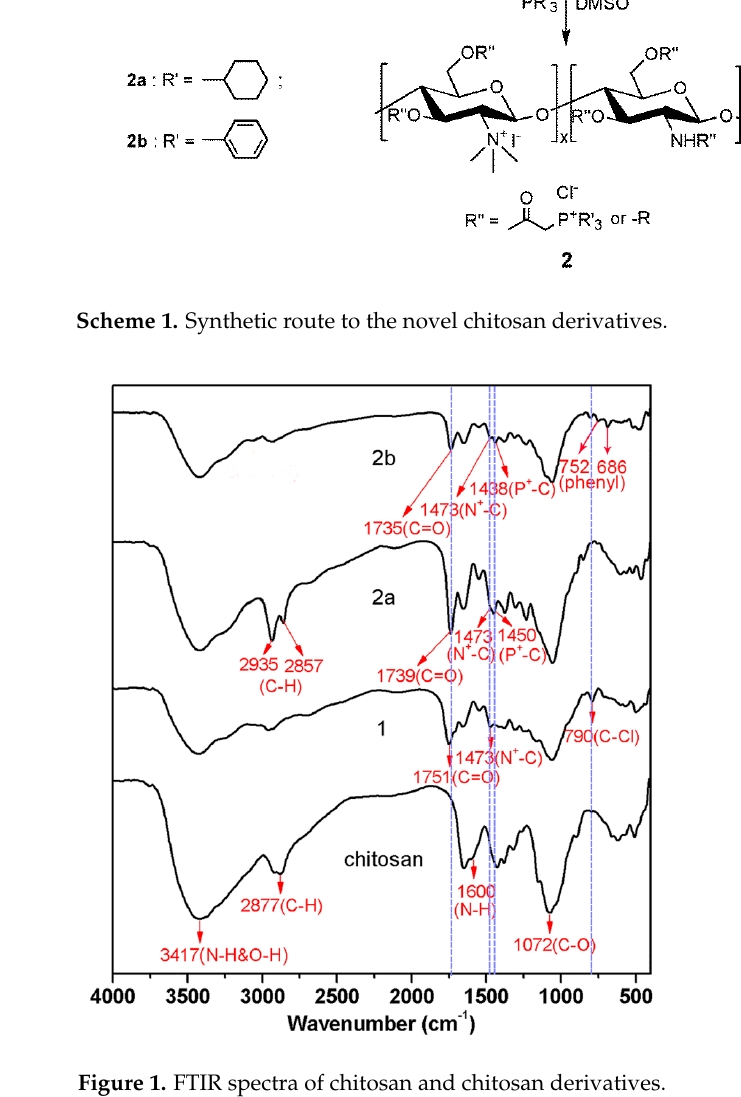
Figure 1. FTIR spectra of chitosan and chitosan derivatives.